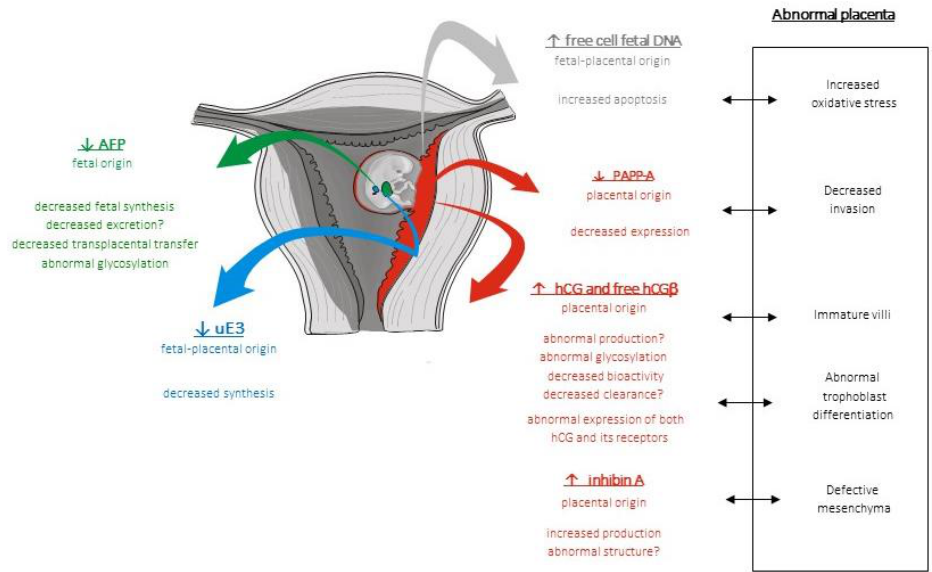
Figure 6. Physiopathology of maternal serum markers in trisomy 21-affected pregnancies. The human placenta releases soluble markers into the maternal blood as well as cells and cell-free DNA. Soluble markers can be of fetal origin, such as the alpha feto protein (AFP), of feto–placental origin, such as the unconjugated estriol (uE3), or of placental origin, such as the human chorionic gonadotropin (hCG) and its free beta subunit (hCG β ), the pregnancy-associated plasmatic protein A (PAPP-A), and the inhibin A (inhibin A). In trisomy 21-affected pregnancies, both placental and fetal functions are disrupted, leading to the decrease ( ↓ ) or the increase ( ↑ ) of their concentrations in maternal blood.